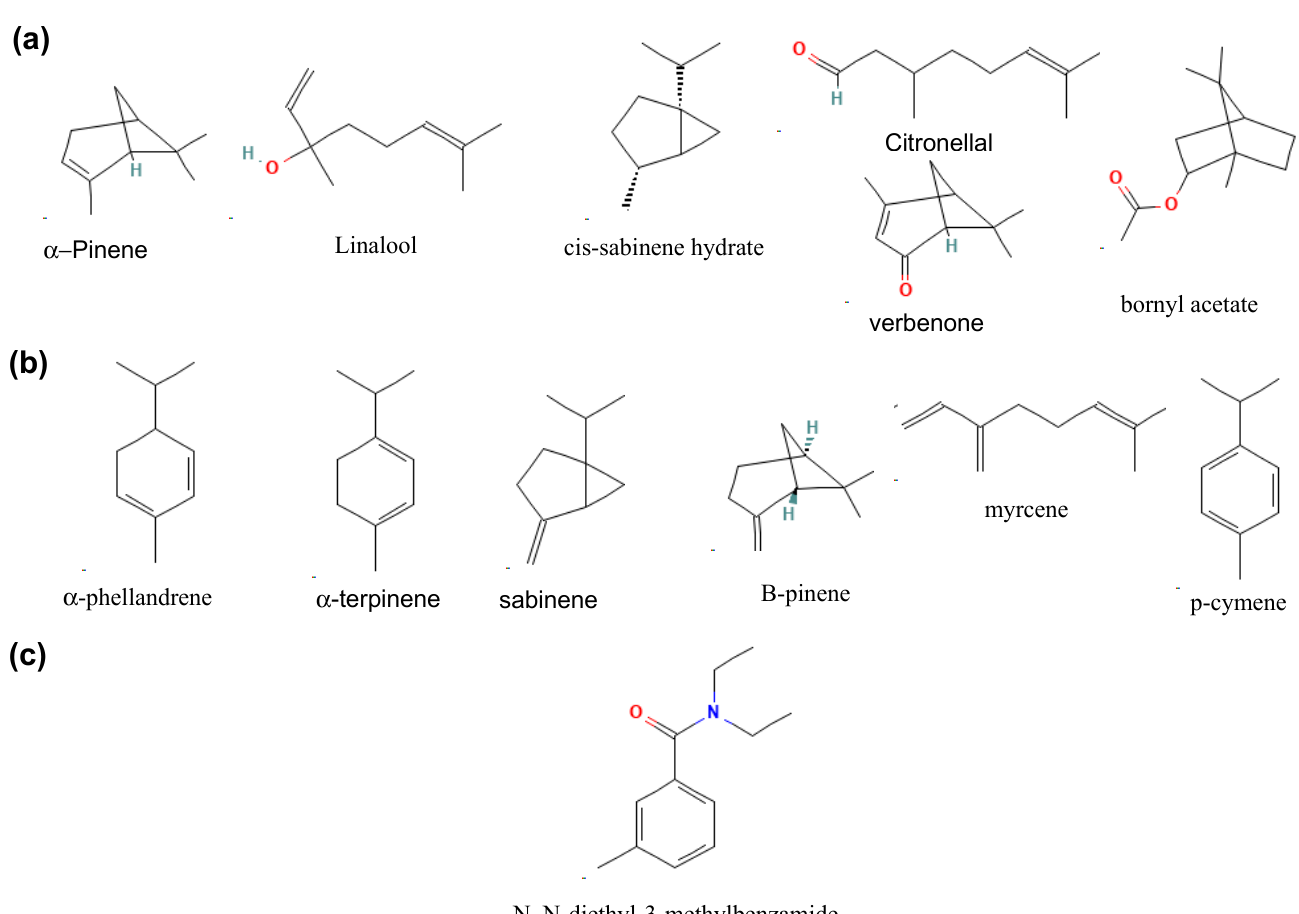
Figure 4. 2D structures of the selected ligands ( a ) found in all essential oils irrespective of collection site, ( b ) with percentage composition ≥ 10%, and ( c ) N,N-diethyl-3-methylbenzamide (DEET).